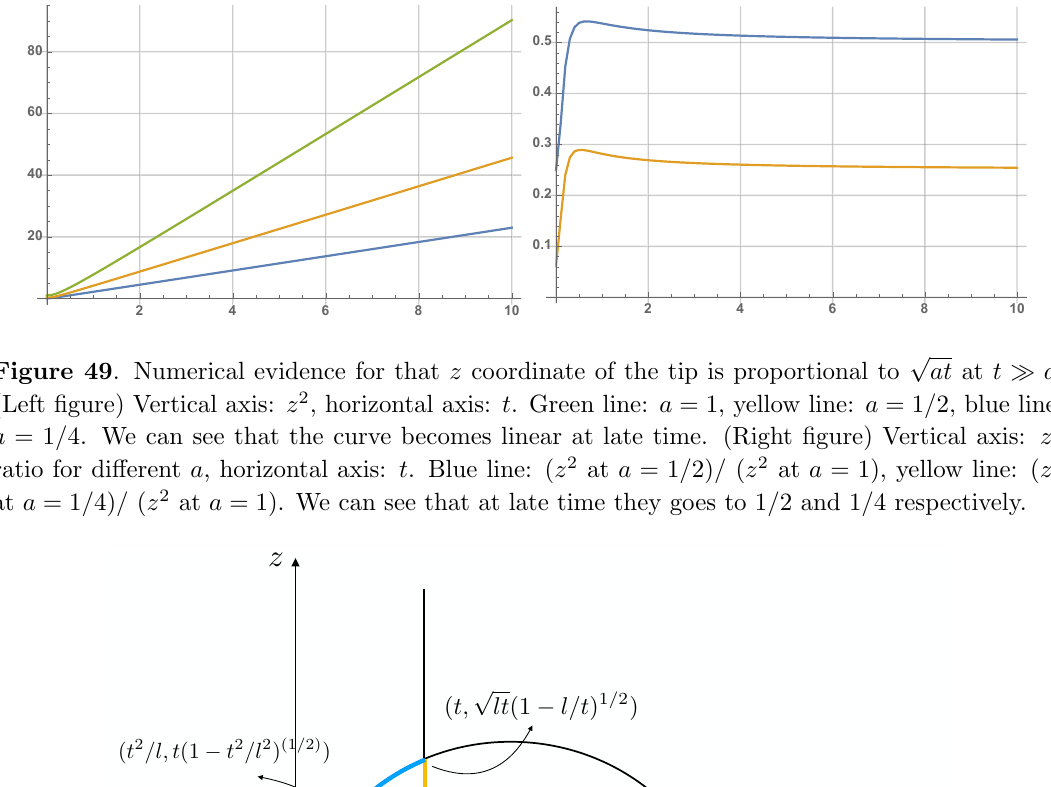
Figure 50 . Evaluating the contribution of making a detour at the sharp corner of the boundary surface on a time slice. We approximately regard the boundary surface as a half circle x 2 + z 2 = t 2 and a vertical line x = t with a cut off √ at at the